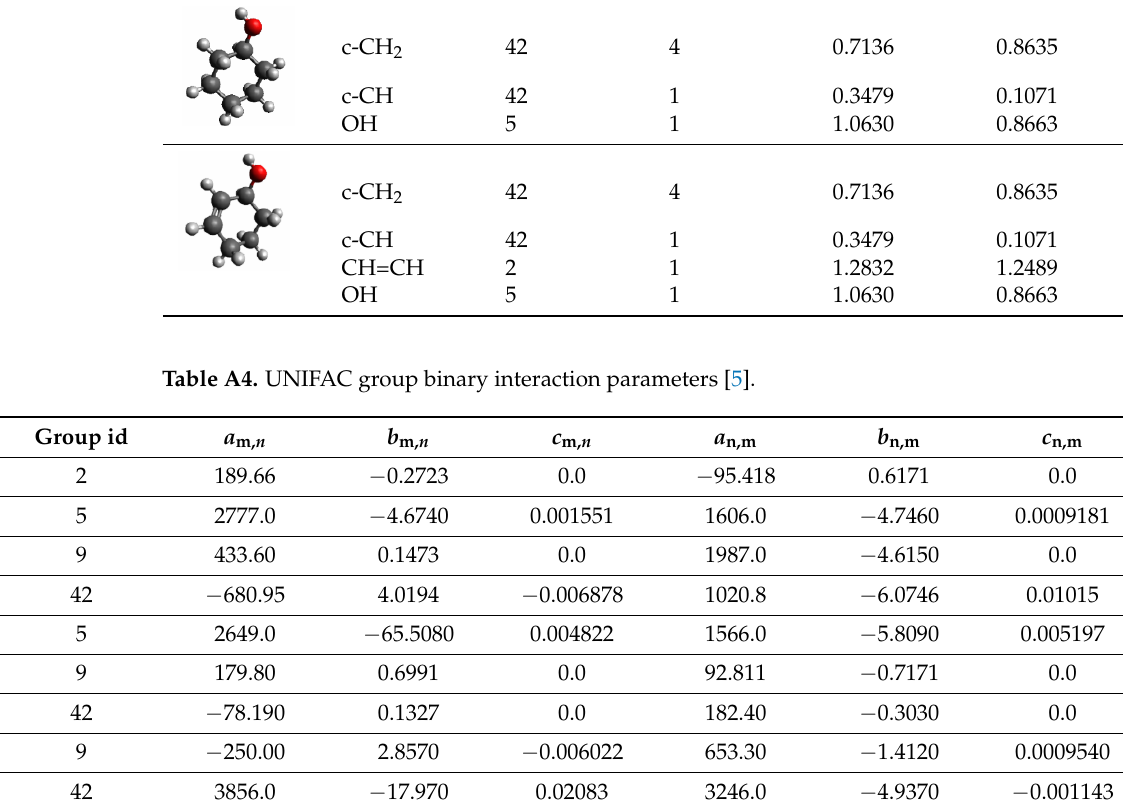
Table A4. UNIFAC group binary interaction parameters [5].